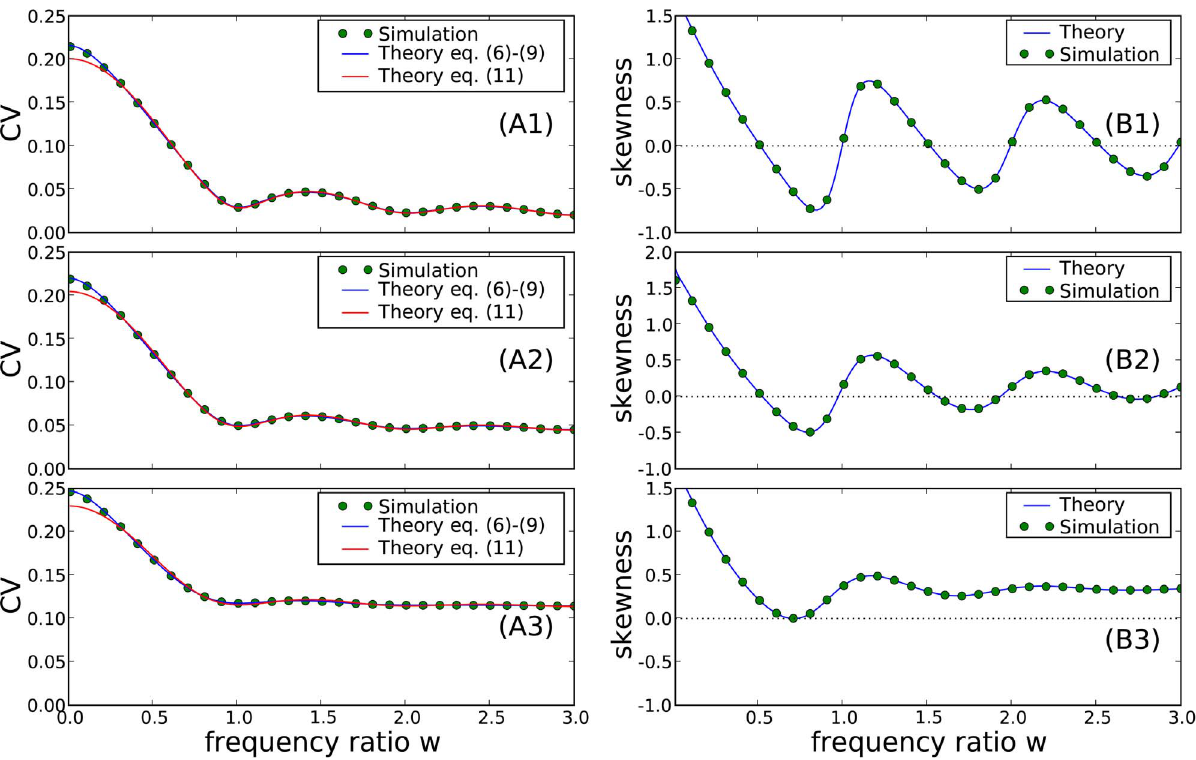
Figure 3. Second and third-order interval statistics as a function of the frequency ratio for different values of the OU broadband input (remaining parameters ^ ss x ~ 0 : 2 , Q ~ 30 : 0 , and ^ tt ~ 0 : 01 ). A : Coefficient of variation (CV) for ^ ss z ~ 0 : 1 (A1), ^ ss z ~ 0 : 3 (A2), or ^ ss z ~ 0 : 8 (A3). B : Skewness c s for ^ ss z ~ 0 : 1 (B1) ^ ss z ~ 0 : 3 (B2), or ^ ss z ~ 0 : 8 (B3). Theoretical CV and skewness (blue) were computed by numerical integration from the theoretical ISI distribution Eq.(6)–Eq.(9) ; the simpler expression Eq.(11) is shown in red in A .